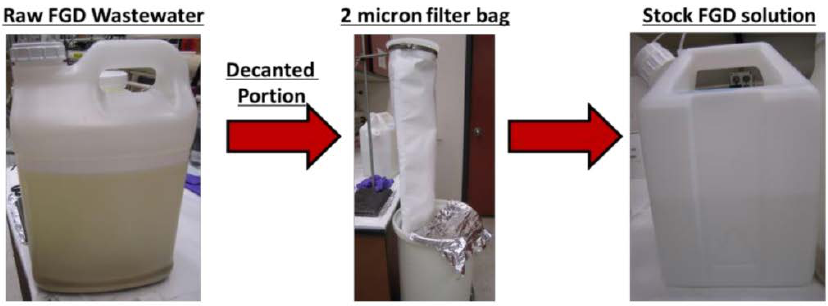
Figure 4. Preparation of stock FGD WW solution. Raw FGD WW was allowed to settle and then decanted. The decanted portion was filtered through a filter bag to produce the stock FGD solution. This stock solution was diluted for RO studies.